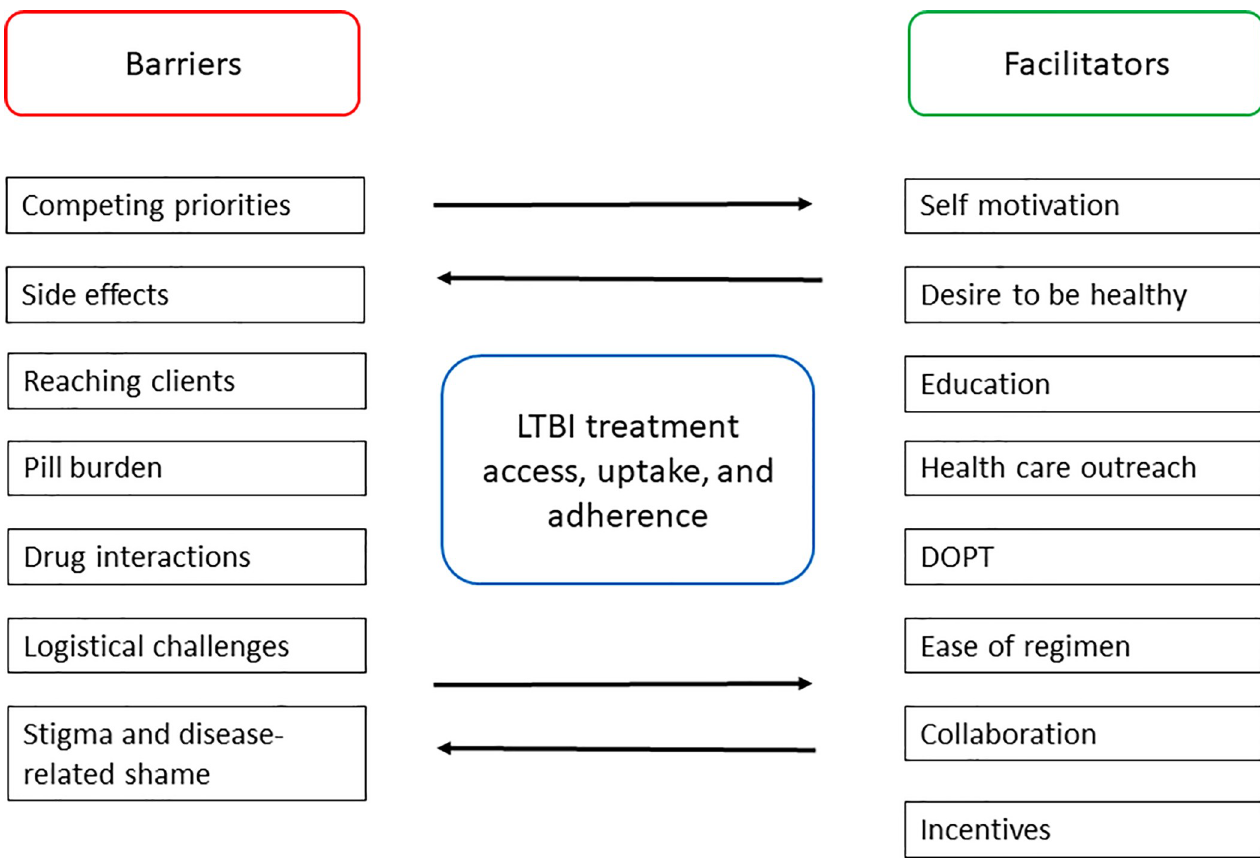
Fig 1. Barriers and facilitators to treatment access, uptake, and